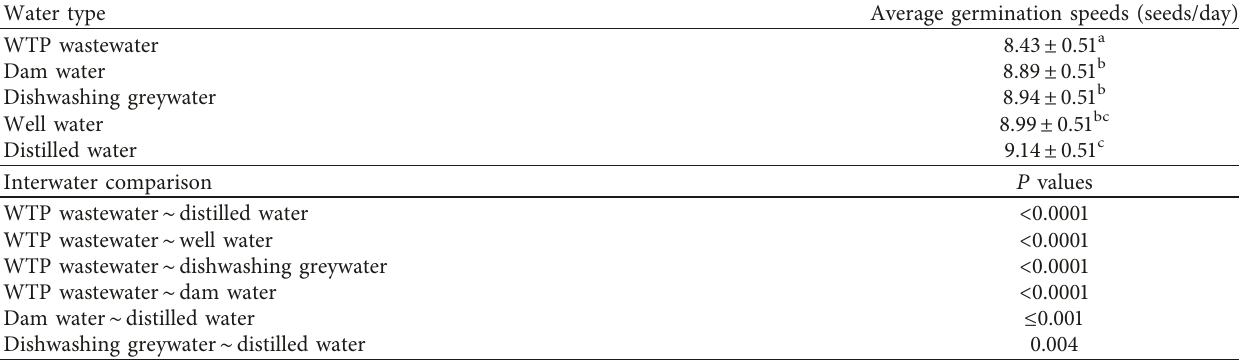
Table 4: Effect of watering water on the germination speed of okra seeds.